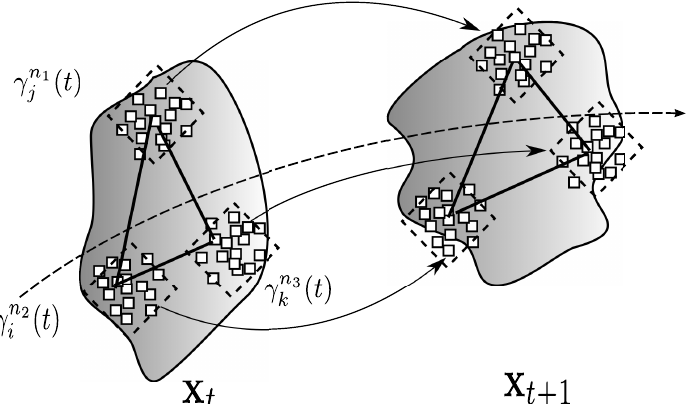
Figure 3: Illustration of the time evolution of a cluster with a constrained SMC